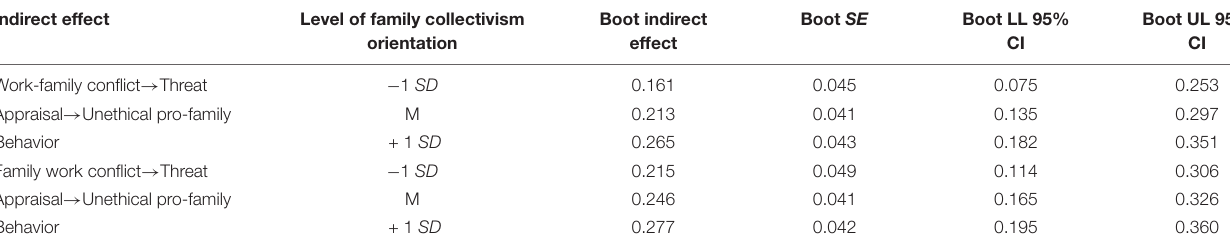
TABLE 4 | Moderated-mediation results at different levels of family collectivism